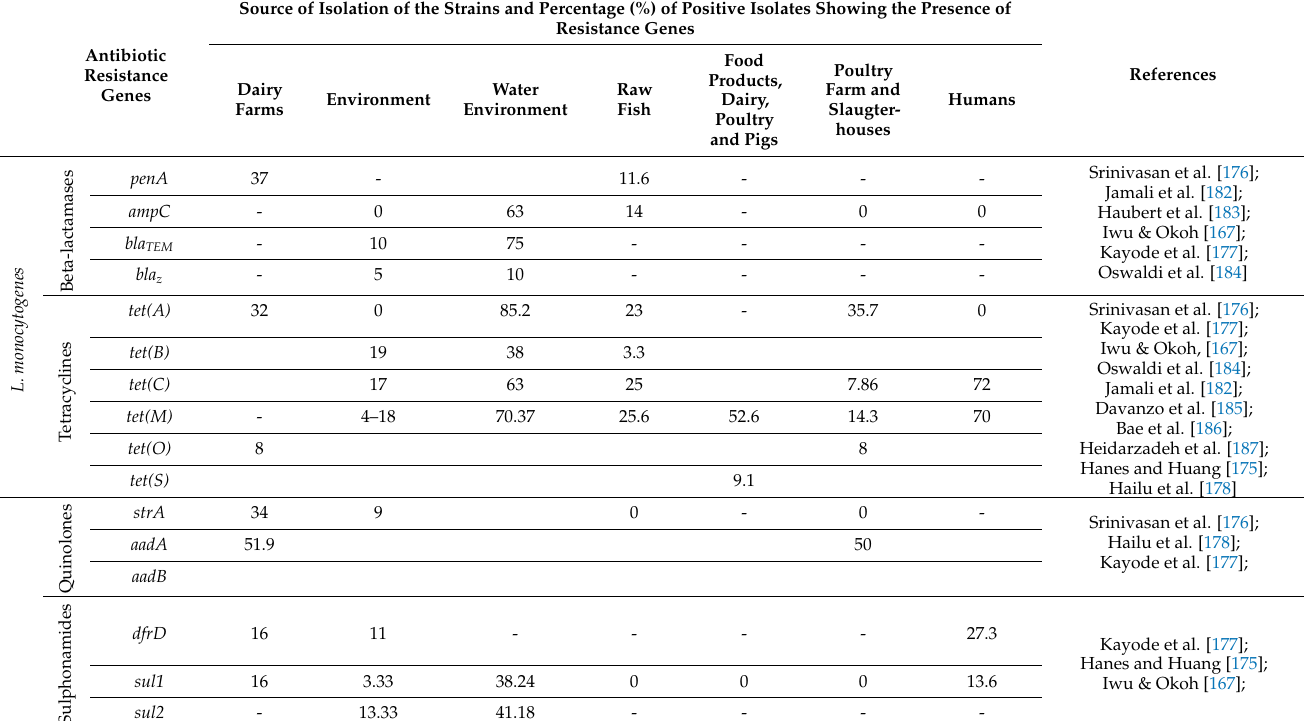
Table 3. Prevalence of specific genes of resistance to selected antibiotics in Listeria spp.